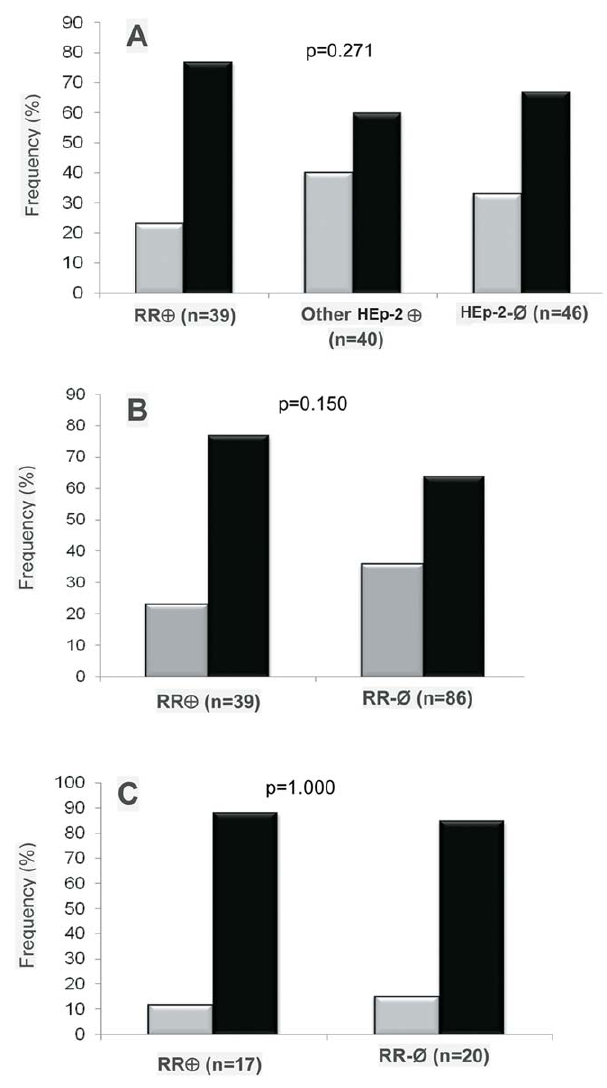
Figure 4. Anti-RR is not related to sustained virologic response. The frequency of samples with RR IIF-HEp-2 pattern, other patterns and those with a negative test was equivalent in patients exhibiting sustained virologic response and those classified as non-responders. (A and B) HCV patients in general; (C) HCV patients with genotype 1 and viral load above 100,000 IU/mL. Gray bars: sustained virologic response; black bars: non-responder patients.